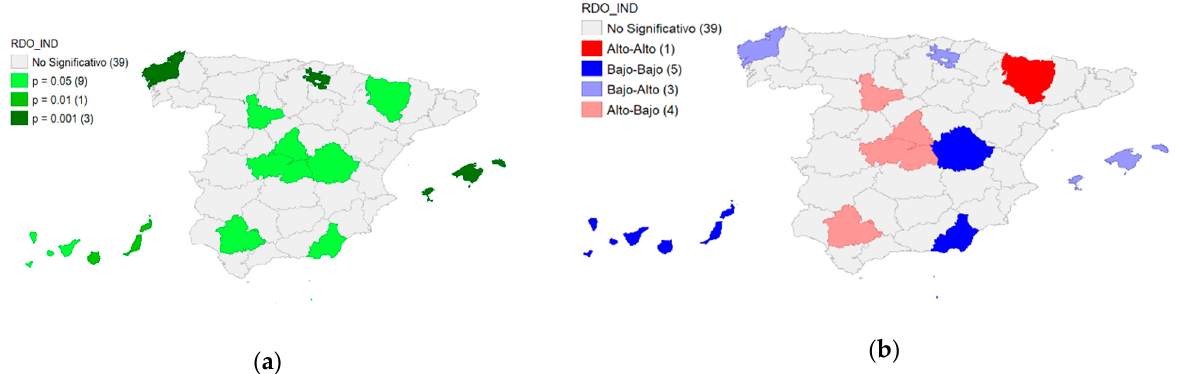
Figure 9. Significance map ( a ) and cluster map ( b ) for manufacturing firms.